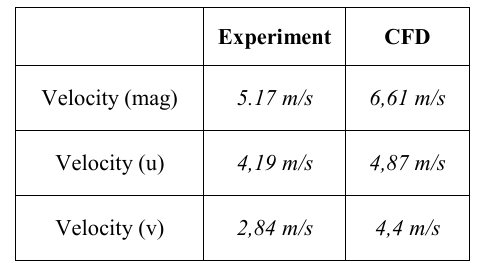
Table 1. Velocity inside investigated region of